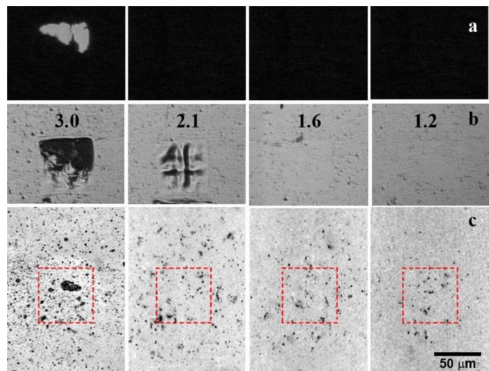
Figure 2. Optical images of the donor substrate covered by the graphene film in the ( a ) transmission and ( b ) reflection modes, and the ( c ) acceptor substrate after the BB-LIFT procedure with a 50 µ m gap between substrates. Numbers correspond to the laser fluence in J / cm 2 used for the transfer.